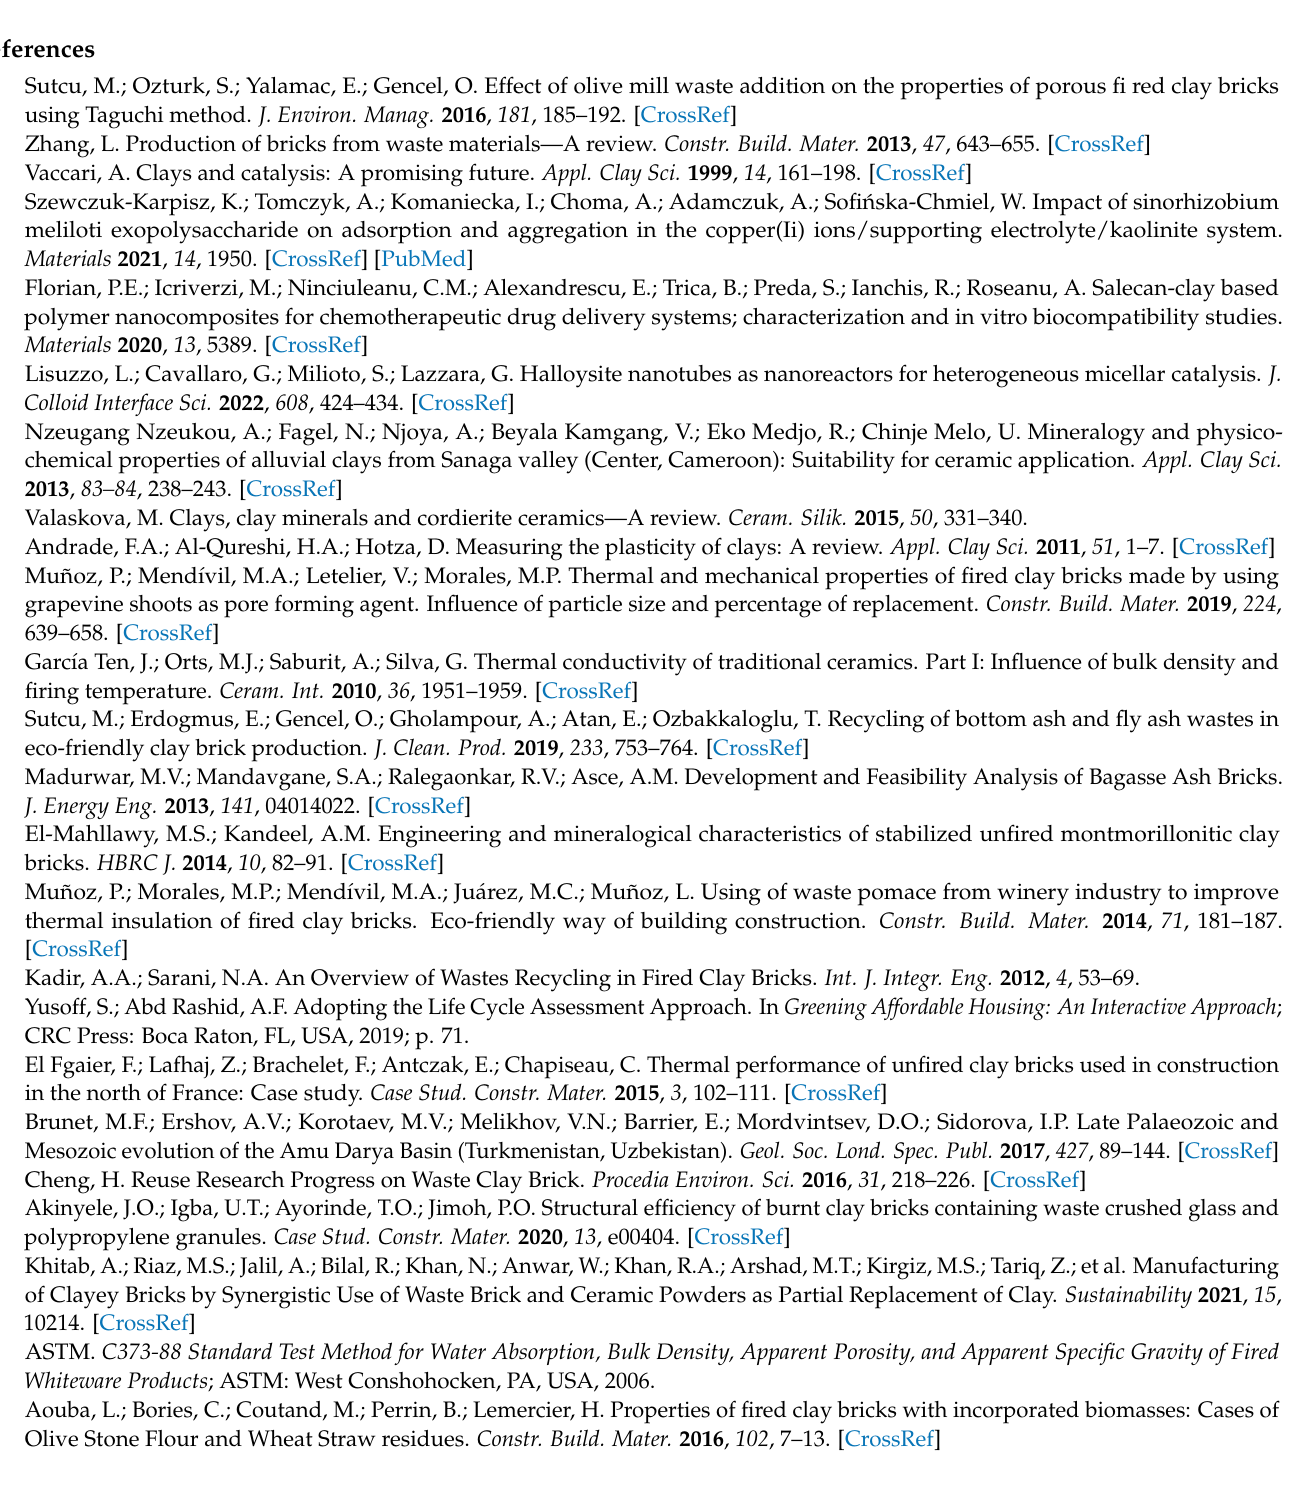
Table A2. The colors of DM, HM, and SM bricks after firing at 850 ◦ C, 950 ◦ C, and 1050 ◦ C. DM HM SM T ( ◦ C) 850 950 1050 850 950 1050 850 950 1050 Brick Colour Red Red Brown Light coral Beige Tan Reddish Cream Dark